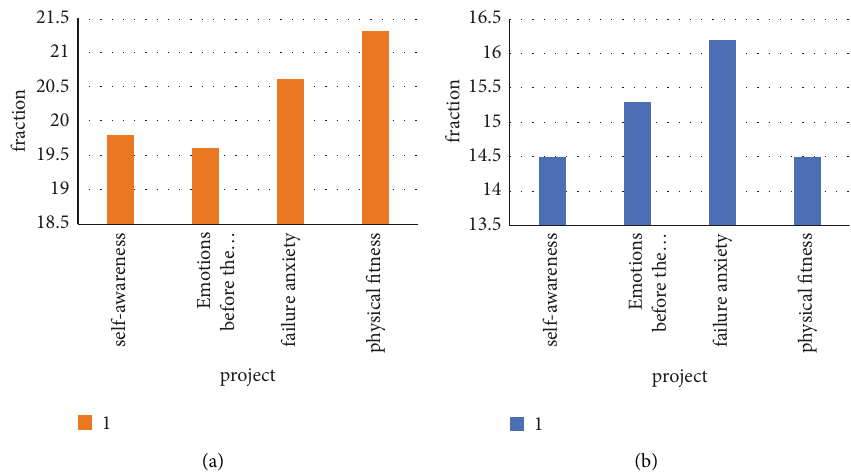
Figure 9: Comparison of psychological anxiety scores. (a) Coach. (b) Machine Learning Algorithms.